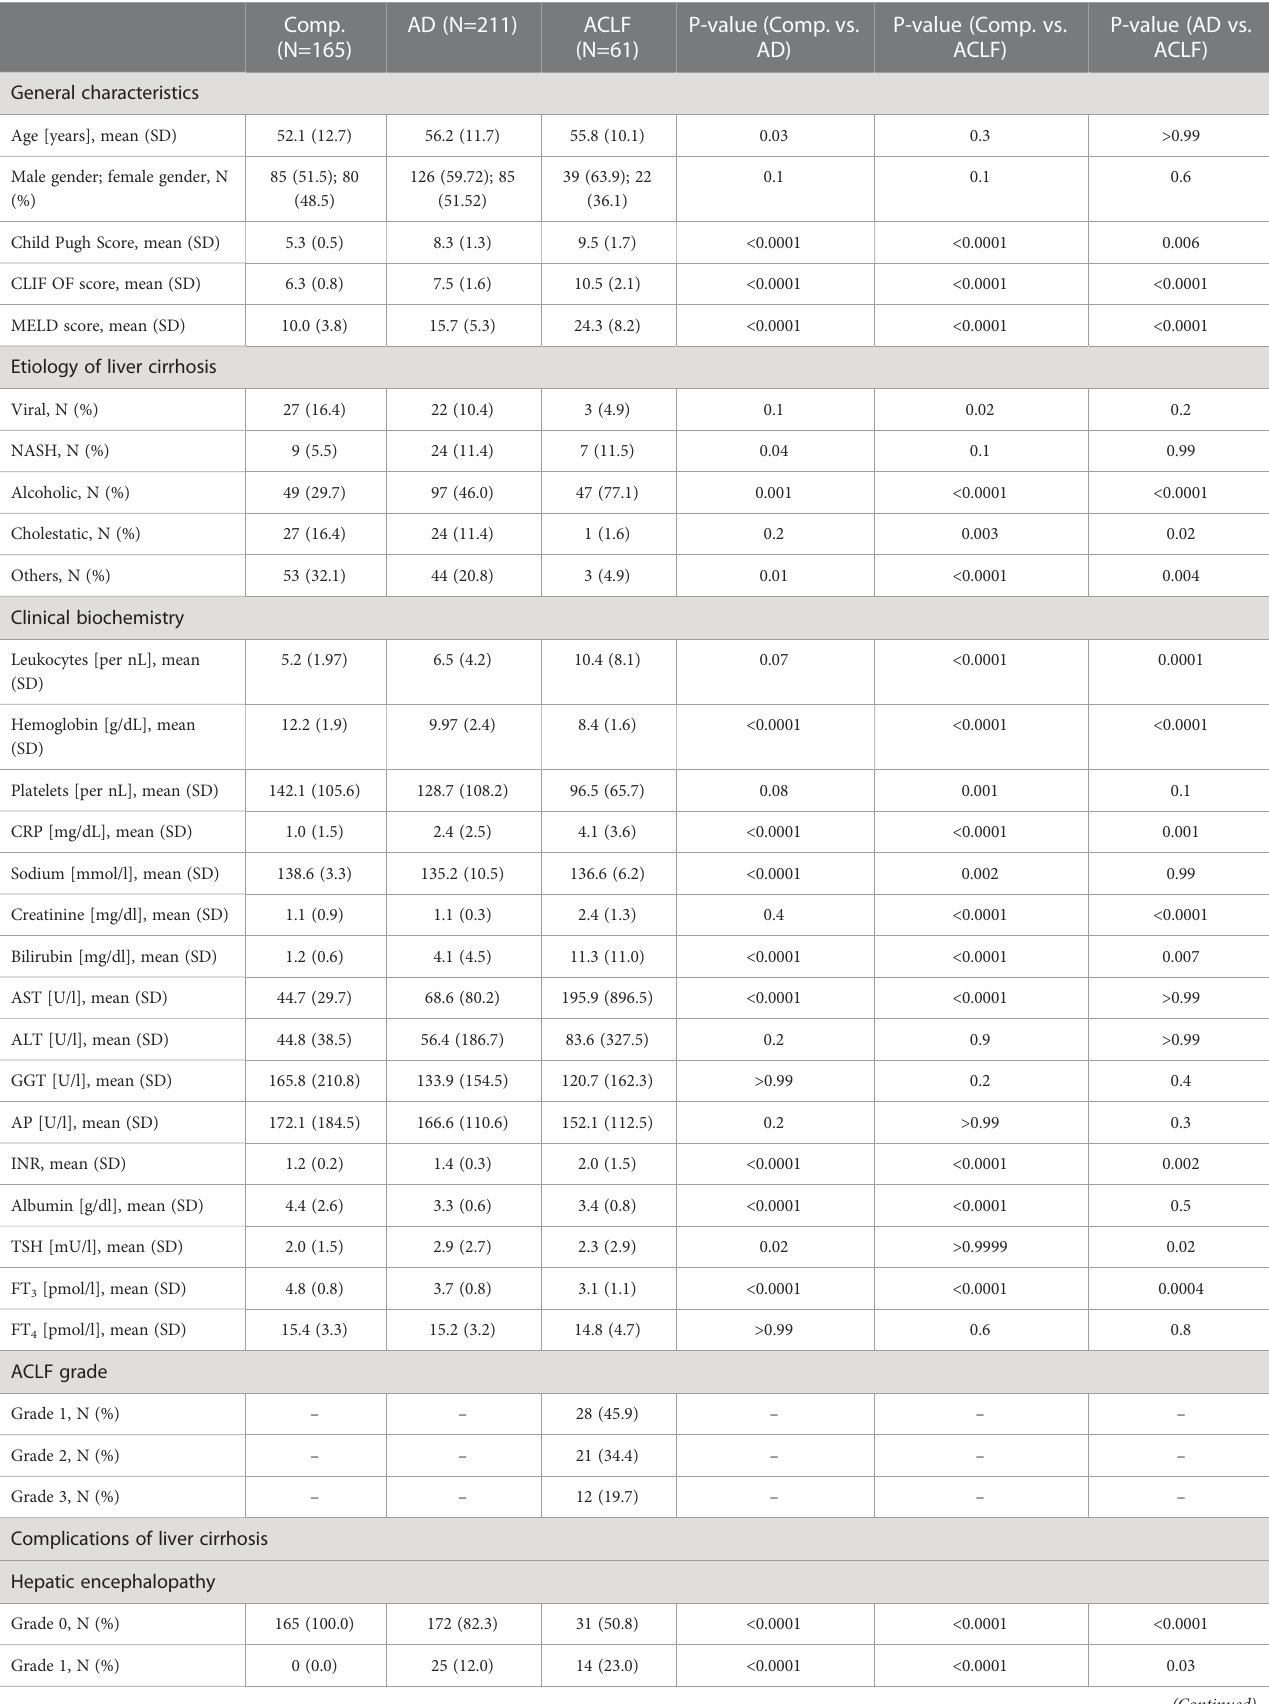
TABLE 1 Baseline characteristics and laboratory results of included patients.